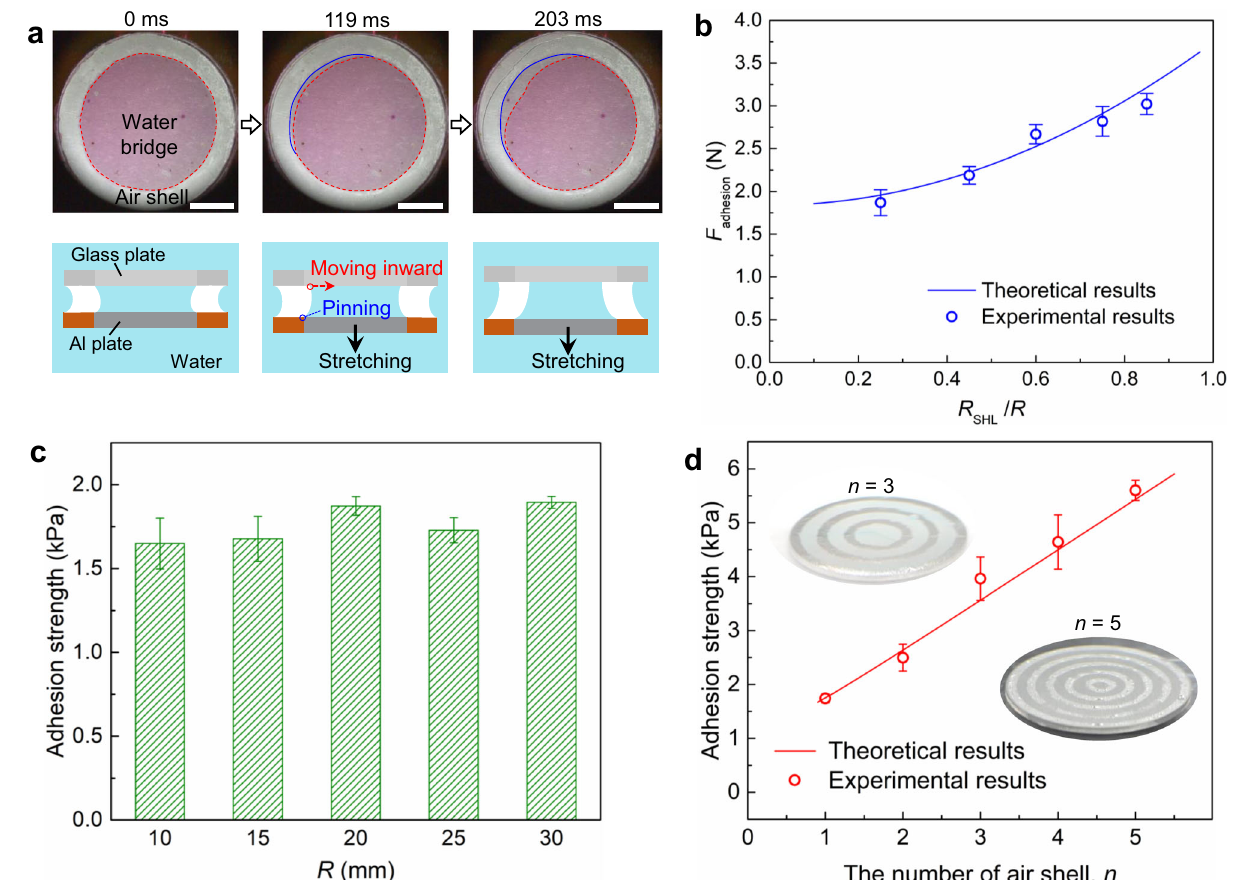
Fig. 3 | Adhesion force analysis and ampli fi cation. a The selected snapshots and theschematicimagesshowingthedynamicsofairshellandwaterbridgeduringthe stretching. Here, the hybrid transparent glass plate is set as the top visualization window. The dark red region with the dotted line and the light red region with the solidlinearethecontactareasofwaterbridgeonthetopglassplateandbottomAl plate, respectively. Here, the scale bar is 1cm. b The variation of theoretical and experimental adhesion force as a function of R SHL / R . Our theoretical results show